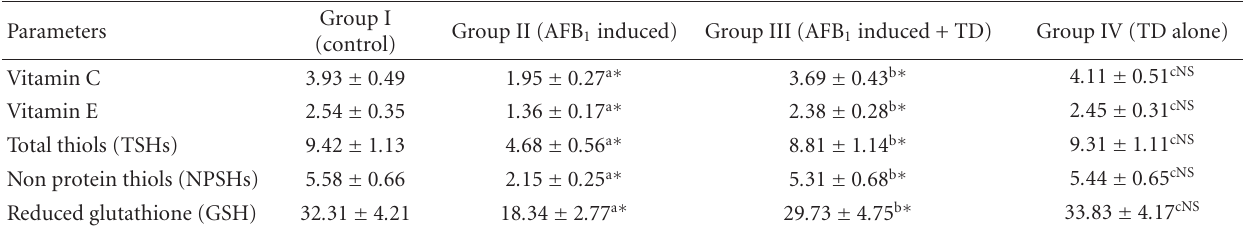
Table 4: E ff ect of TD on nonenzymic antioxidants and thiols in liver of control and experimental animals.